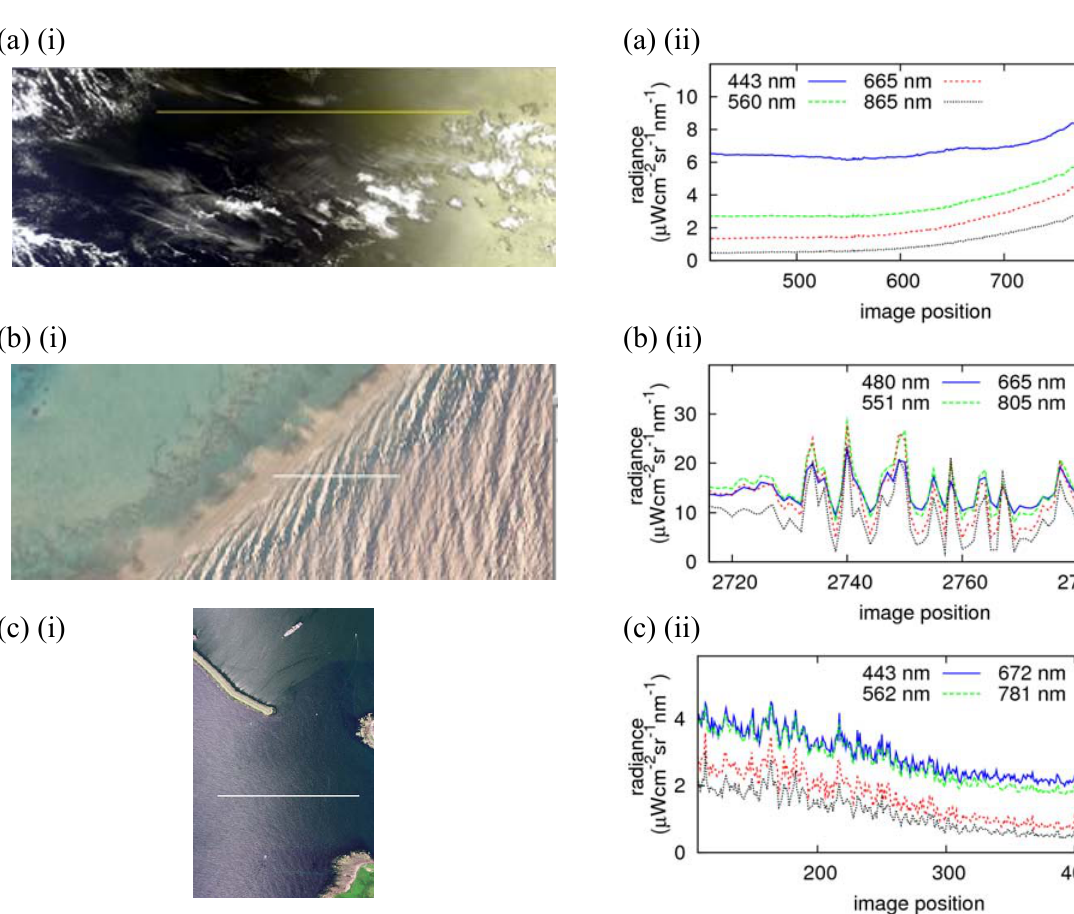
Figure 1. Illustration of sun glint in a variety of optical imagery. See Table 1 for sensor information. (a)(i) Sub-set of a MERIS image of the Pacific Ocean, showing sun glint on the right hand side. (a)(ii) Sensor radiance plotted for 4 wavebands along the line marked in (a) (i). (b)(i) IKONOS image of Glovers Reef, Belize, showing glint from waves in the lower right part of the image, with bright peaks corresponding to individual waves. (b)(ii) Sensor radiance plotted for 4 wavebands along the line marked in (b)(i). (c)(i) Cross-track glint in a CASI image of Plymouth Sound (UK); showing glint on the left hand side. (c)(ii) Sensor radiance plotted for 4 wavebands along the line marked in